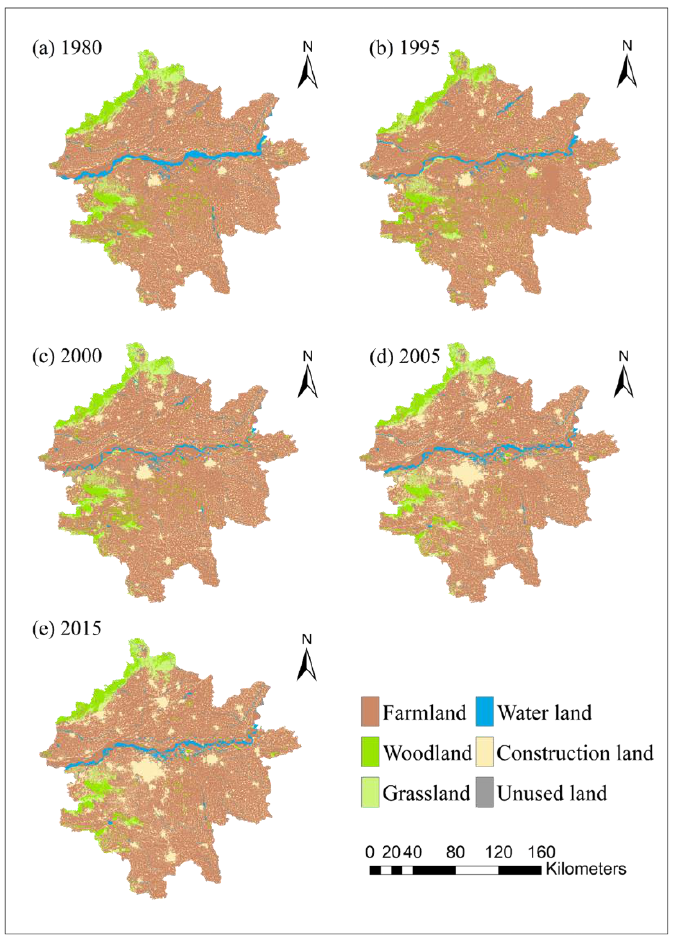
Figure 2. Distribution results of land use types in ( a ) 1980, ( b ) 1995, ( c ) 2000, ( d ) 2005, and ( e ) 2015.